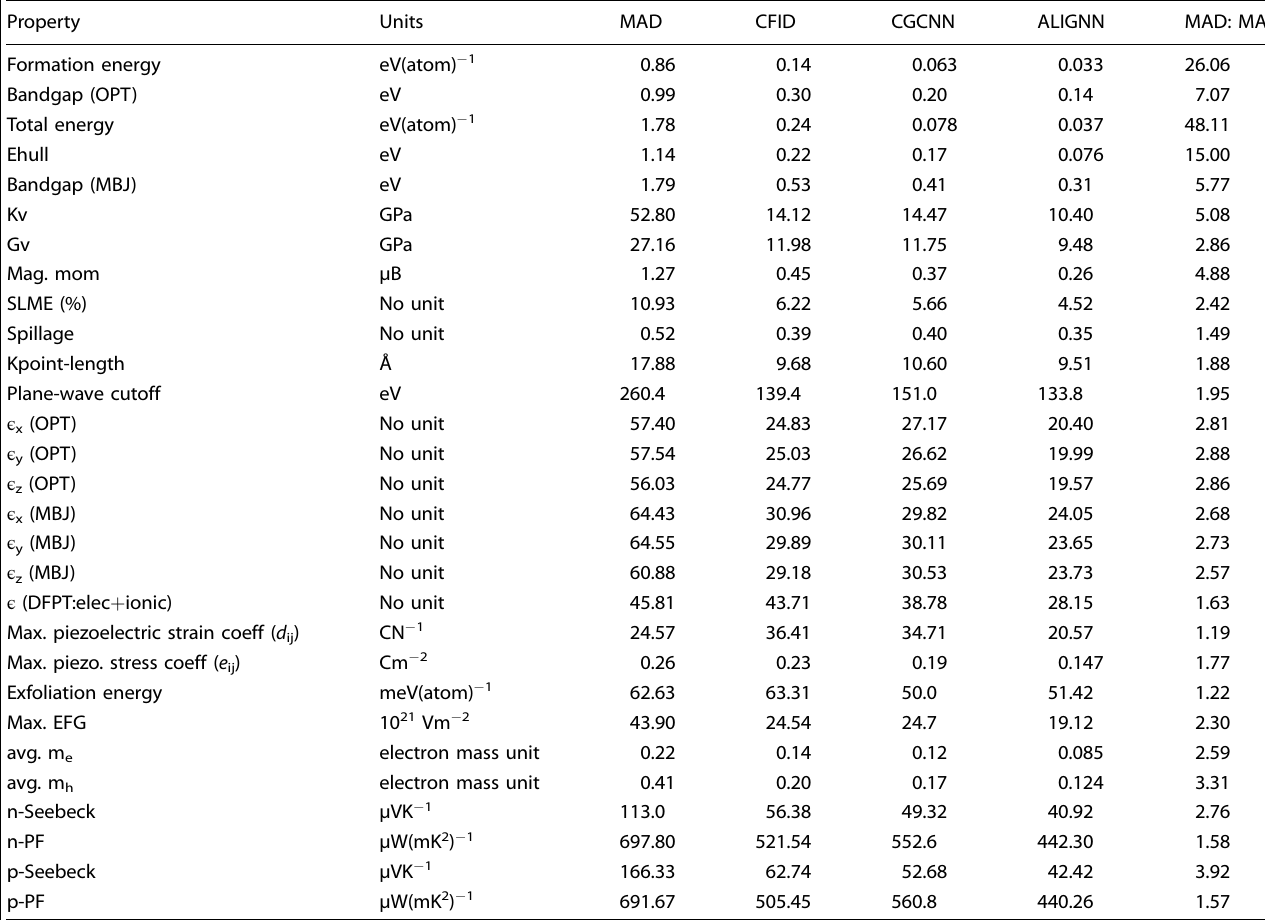
Table 3. Regression model performances on JARVIS-DFT dataset for 29 properties using CFID, CGCNN and ALIGNN models on 55,722 materials.